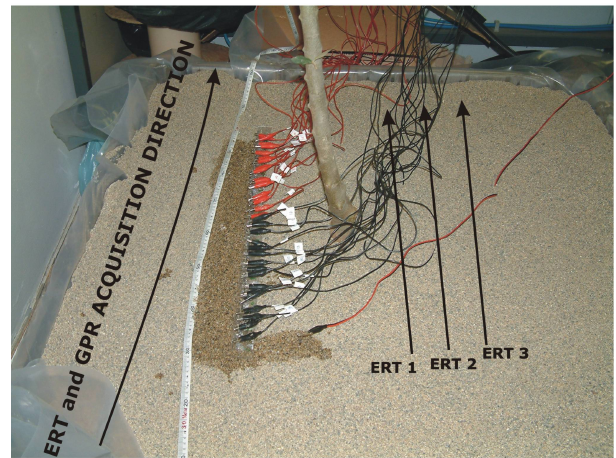
Fig. 1. Locations of geophysical surveys in woody box with peach tree planted at the